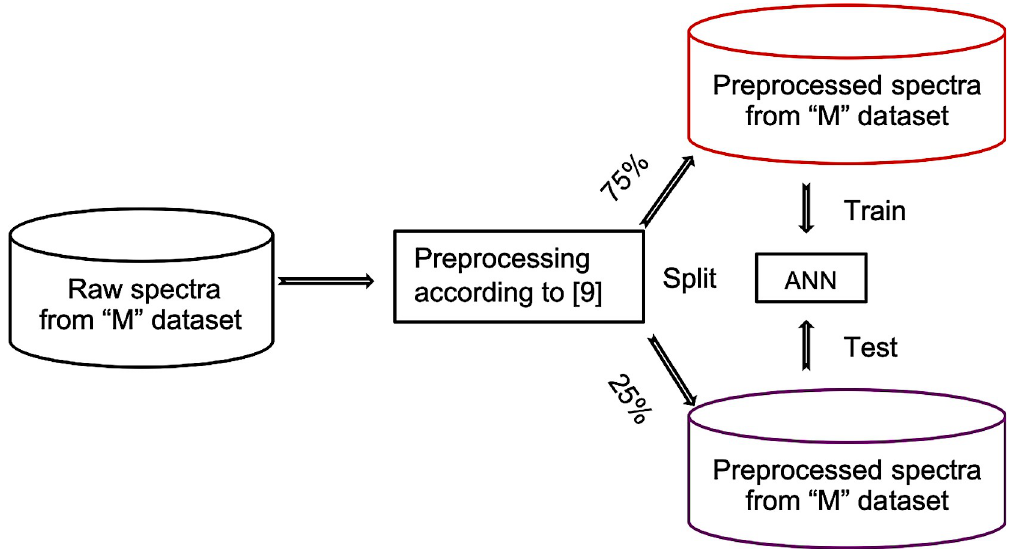
Fig 1. Training and testing ANN model on spectra preprocessed according to Mayagaya et al. [9]. “ M” is either Minepa- ARA, Muleba-GA, Burkina-GA, or Muleba-Burkina-GA.